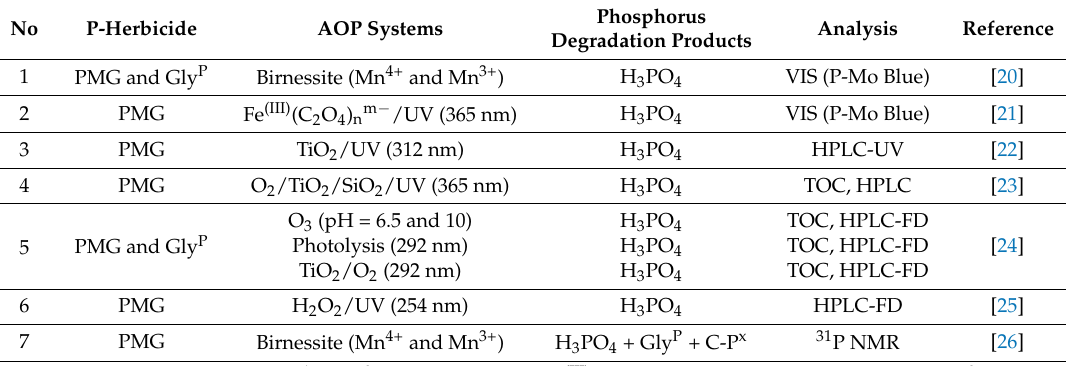
Table 1. Representative applications of advanced oxidation process (AOP) technology in the chemical degradation of N -(PhosphonoMethyl)Glycine (PMG) and aminomethylphosphonic acid (Gly P ).